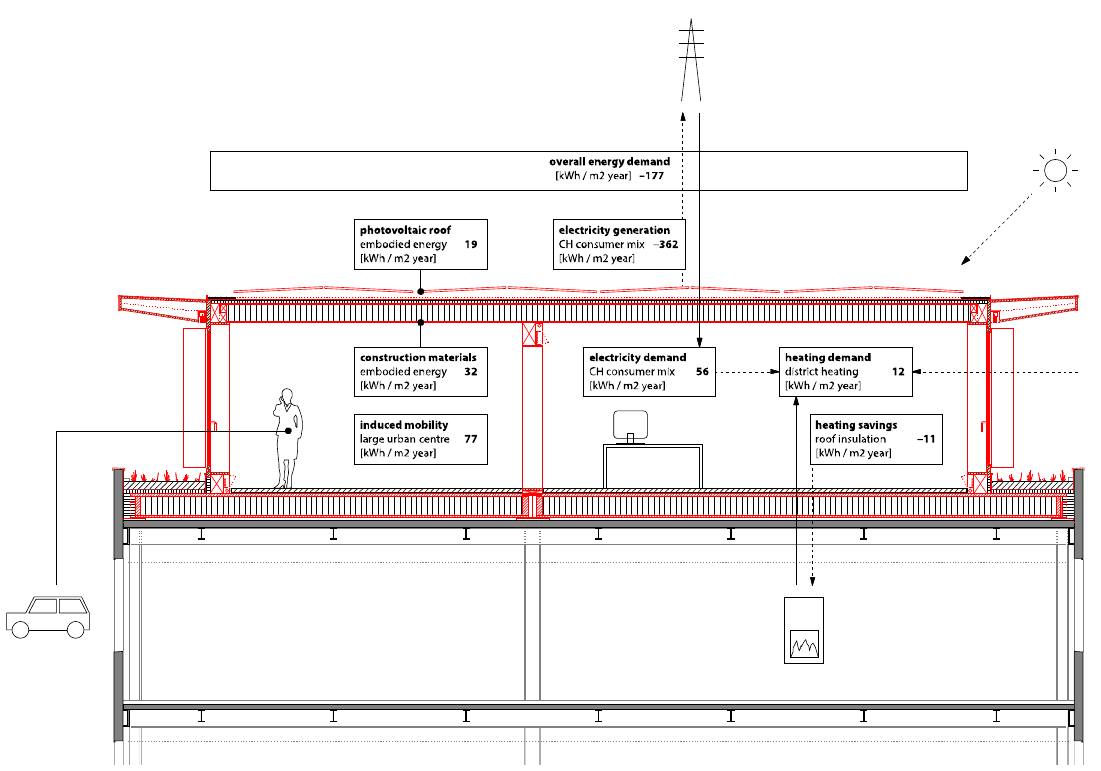
Figure 5. Section through the extension, showing the framework and results of the energy balance. Elements in red refer to the new construction, while elements in black refer to the existing building.